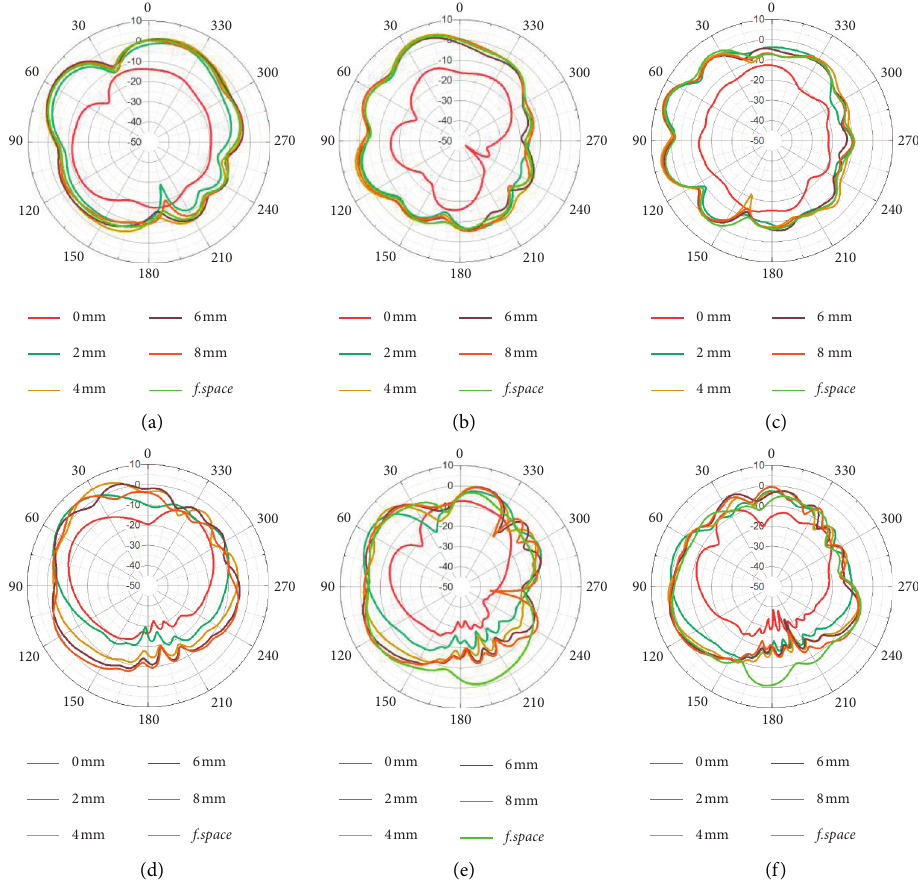
Figure 12: Polar plot antenna radiation patterns in the XY-plane at (a) 60GHz, (b) 80 GHz, and (c) 100GHz form different distances. Polar plot radiation patterns on YZ-plane at (d) 60GHz, (e) 80GHz, and (f) 100GHz from different